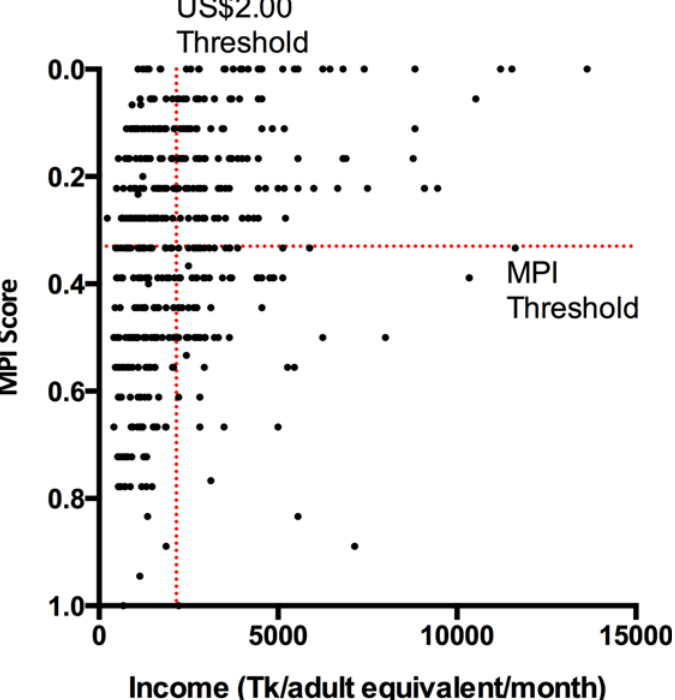
Fig 2. MPI score vs . average household income per adult equivalent per month. The correlation is significant with a P-value of < 0.001 and a Spearman ’ s rho of -0.37. Thresholds for MPI and US$2.00 daily income per adult equivalent (adjusted to the World Bank ’ s private individual purchasing power parity estimate) are shown for reference. 56% of study households fall below the wealth threshold of US$2.00/adult/ day, and 51% fall below the MPI threshold for classification as multidimensionally